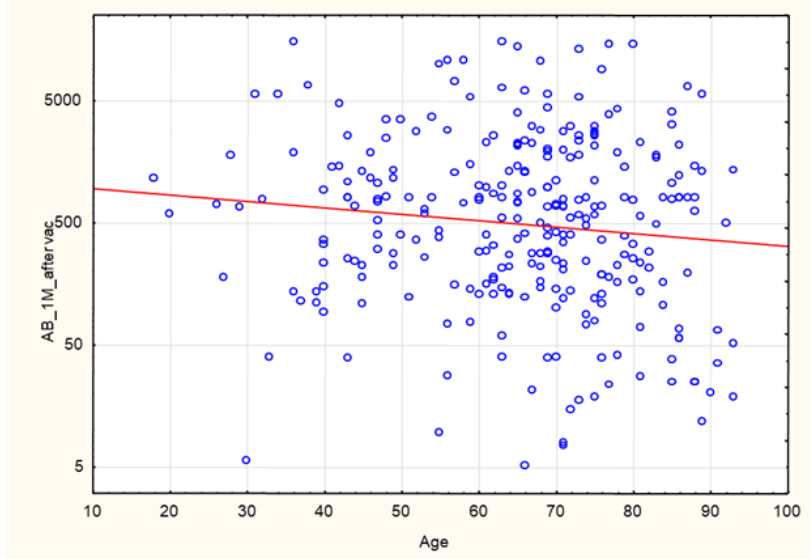
Figure 11. Negative correlation between age (years) and anti-SARS-CoV-2 antibody levels (AU/mL) at 1 month after completion of the vaccination course ( p = 0.04; R –0.12). Spearman’s rank correlation test. AB: antibody. A negative correlation was found between age and AB levels before and after com- pletion of the vaccination course ( p = 0.026; R − 0.14). The correlation is statistically significant, although the strength of the relationship between the examined factors was weak (Figure 12).